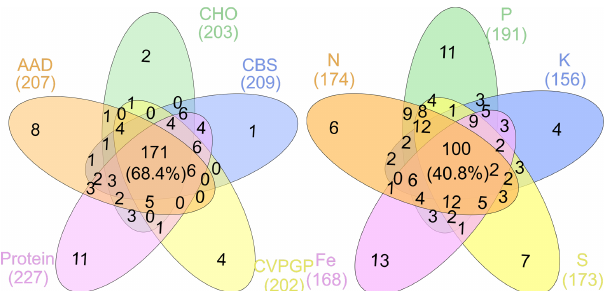
Figure 4. Taxonomic compositions shared among broad and nar- row functions. The Venn diagram shows the dominant microbial taxonomic groups (mean > 0 . 1%), annotated using RefSeq at the genus level (taxonomy), that are shared among broad and narrow